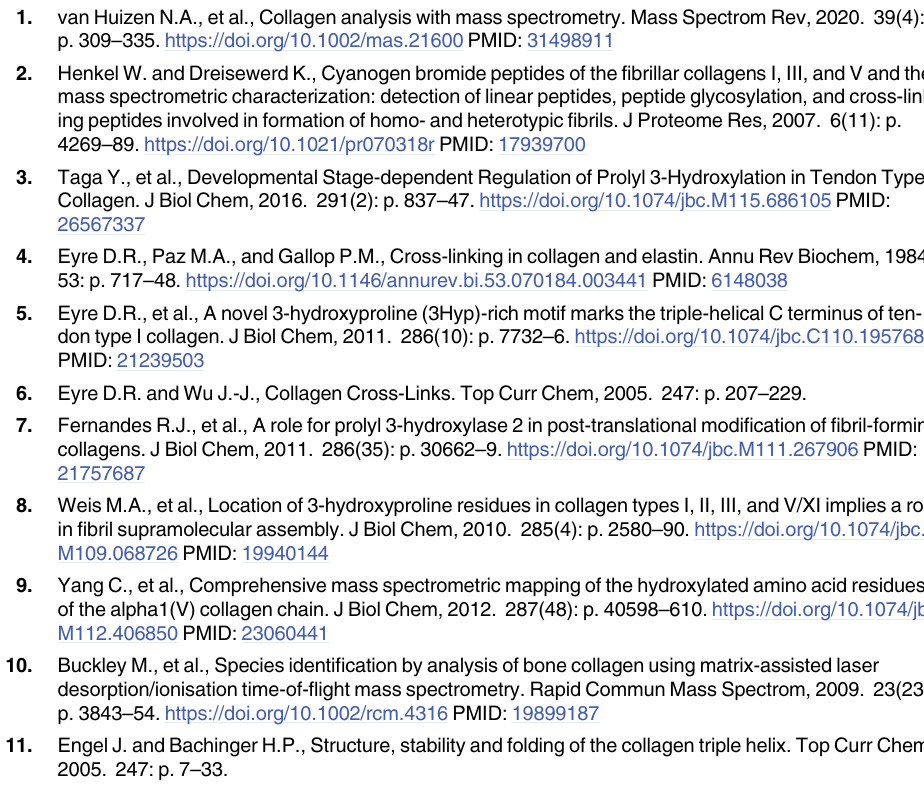
S3 Fig. Uncropped gel of collagen type I. From left: Lane 1 = high range molecular marker, Lane 2 = molecular marker, Lane 3 = collagen type III, Lane 4 = BSA, Lane 5 = low range molecular marker. The rest lanes of the gel were empty. Lanes 2 and 3 are used in S1 Fig.